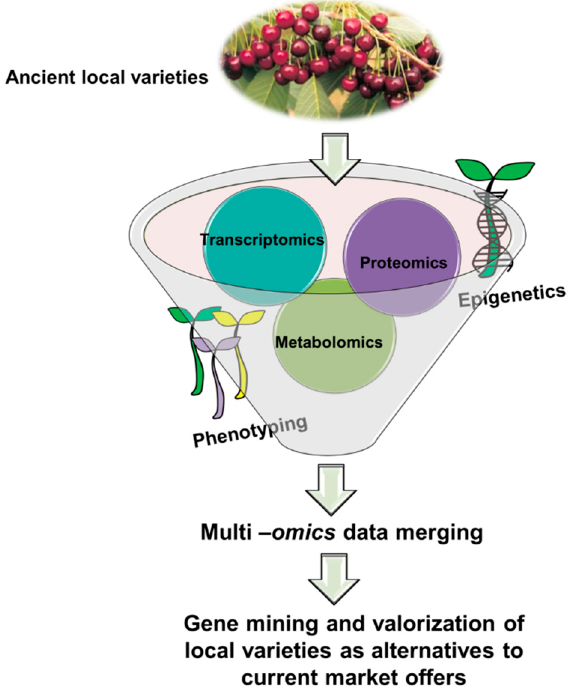
Figure 1. Multi-pronged approach on ancient local varieties. The sweet cherry variety Morellona is shown; image taken from the repository (http://germoplasma.regione.toscana.it/index.php?option=com_content&view=article&id=4&Itemid=109). Such an approach can combine -omics with epigenetics and phenotyping to find genes of interest that could then be used for biotechnological applications. The ultimate goal is to promote